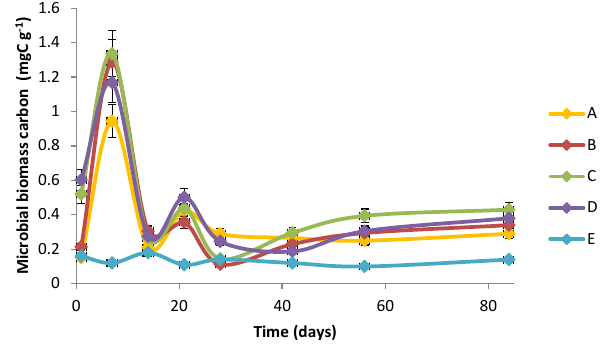
Figure 3. Changes of microbial biomass carbon levels in remedi- ated soil (A, B, C, D, E – as in Fig.